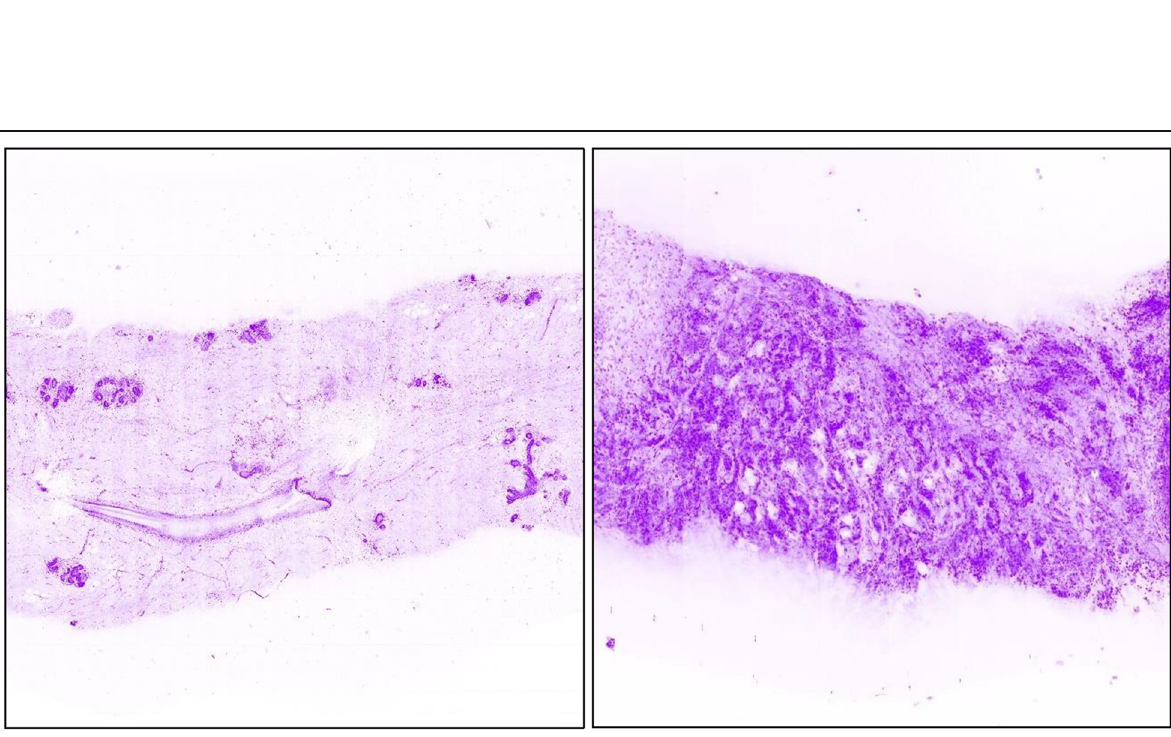
Fig. 3 Zoomed details of the microscopic scanner images with artificial coloring of the grey values: normal breast tissue (left side) and invasive carcinoma (right side)